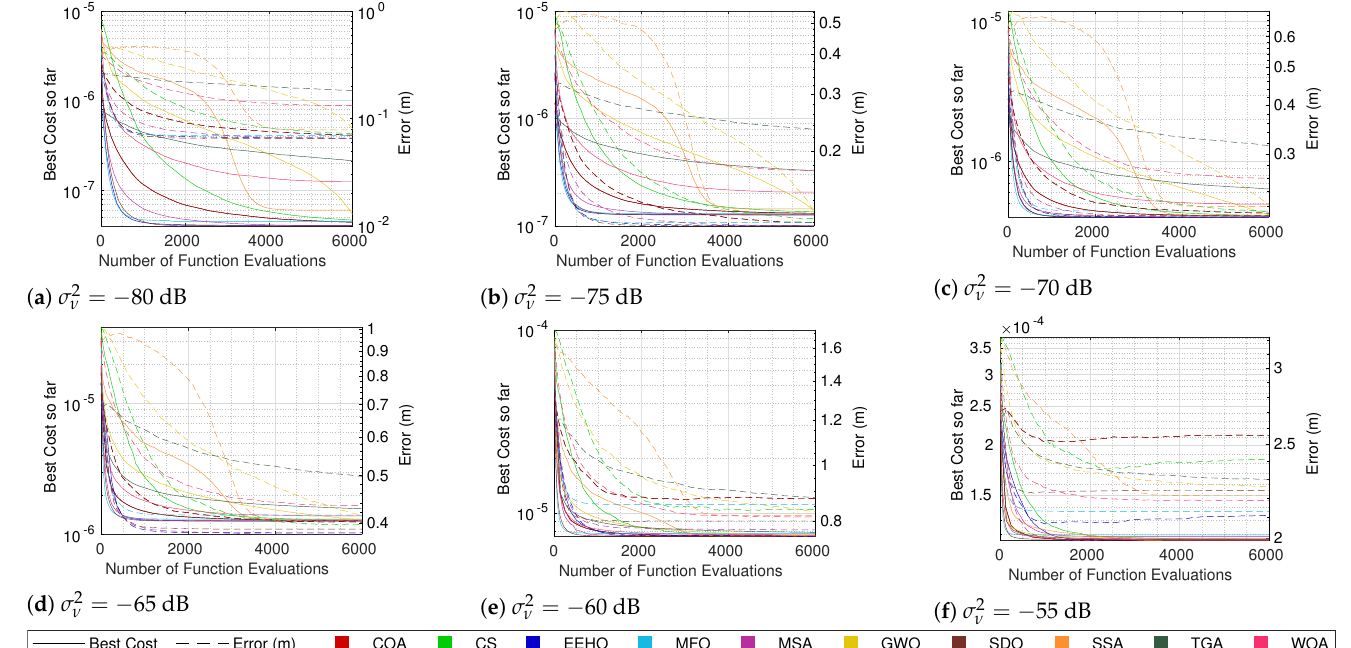
Figure 3. Cost convergence and respective error for each algorithm when N = 6.